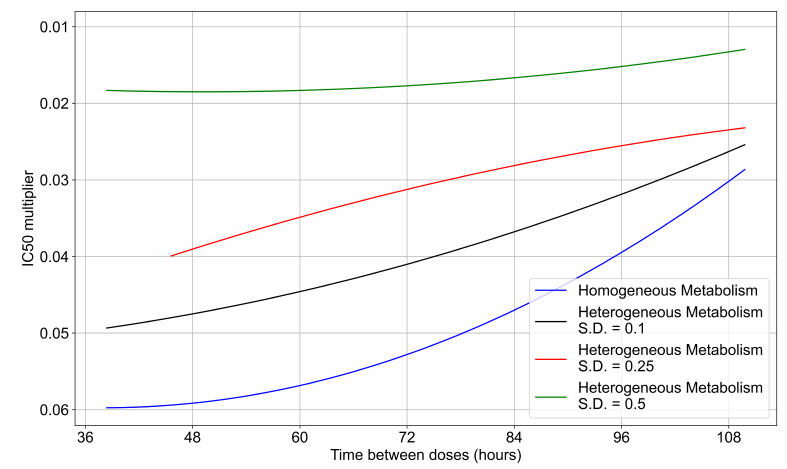
Figure 14. Ineffective–effective treatment transition border for different levels of metabolic variability. In blue is the homogeneous metabolism case, in black the heterogeneous metabolism case applying a modulation by a Gaussian random number with standard deviation (S.D.) set to 0.1 for k in and k out , in red the heterogeneous case with the Gaussian random number S.D. set to 0.25, in green with the S.D. set to